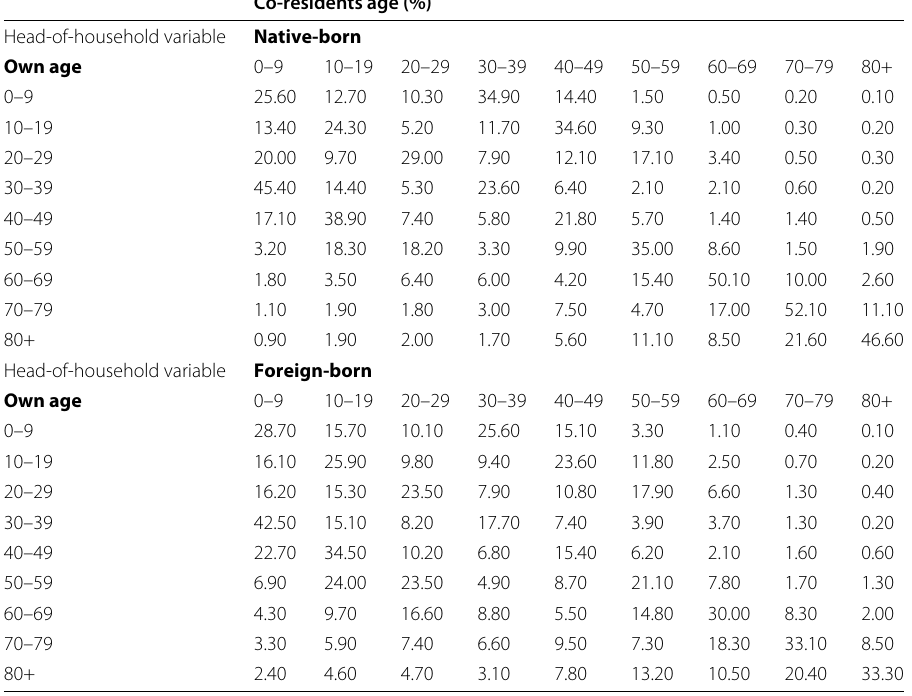
Table 9 Share of co-residents members by age and head-of-household nativity status Head-of-household